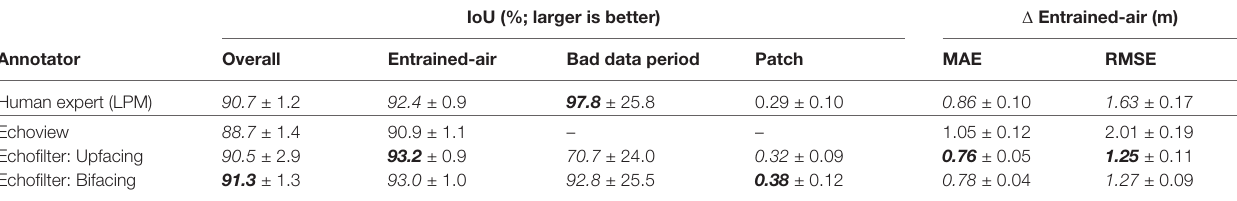
TABLE 5 | Comparison of agreement between several annotation sources.